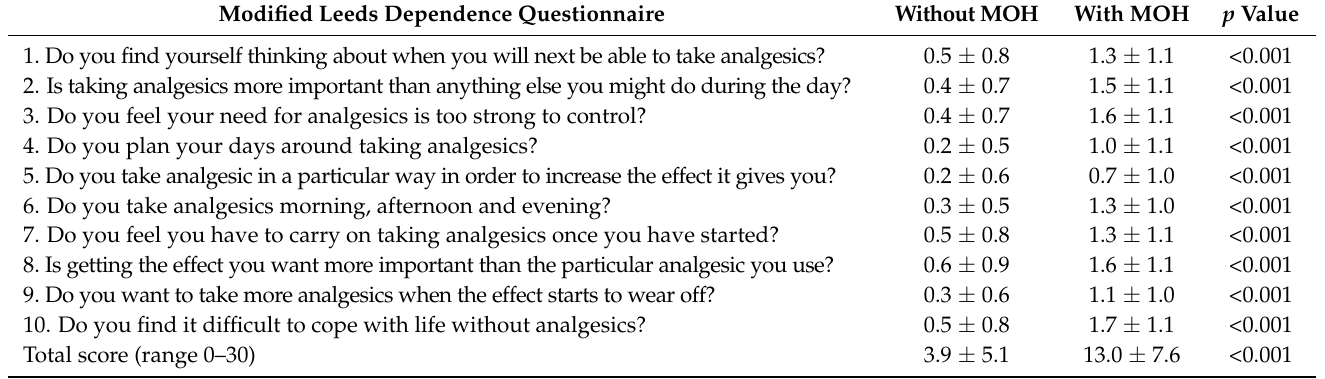
Table 2. Dependence behaviors in patients with and without medication-overuse headache